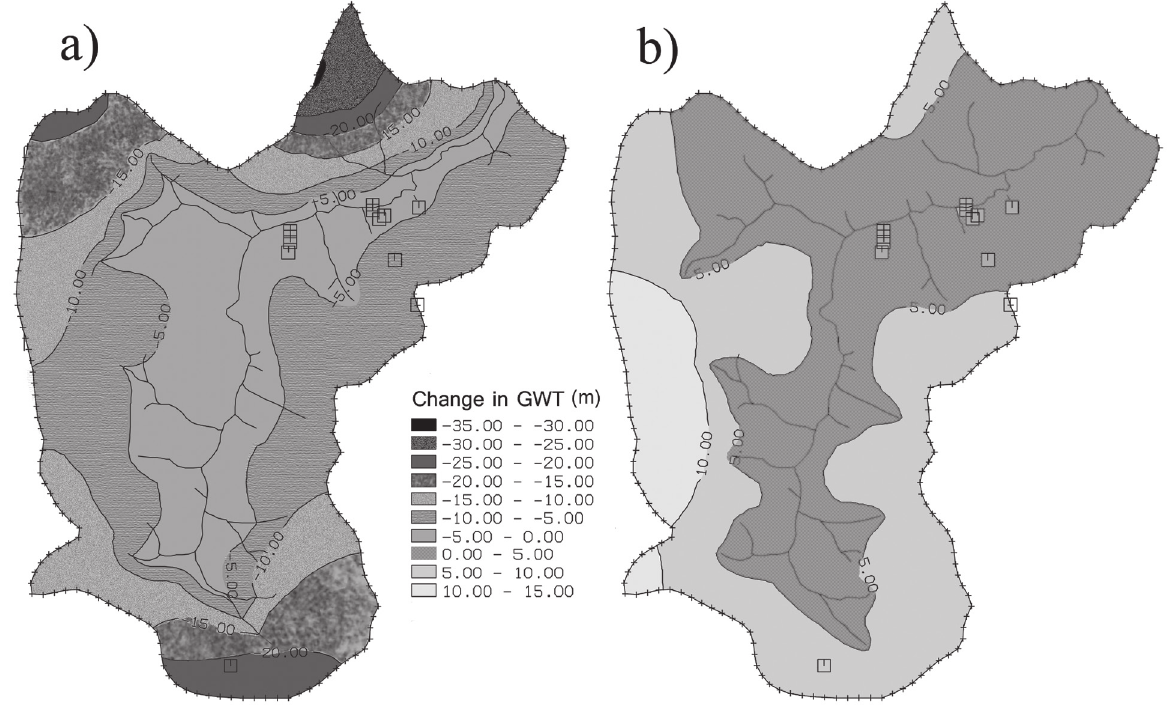
Figure 9 - Spatial changes in groundwater table under a pessimistic (MIROC H) (a) and optimistic (CSIRO Mk3.5) (b) scenario. These changes are the results for steady-state runs considering long-term (2081-2099) averages of recharge